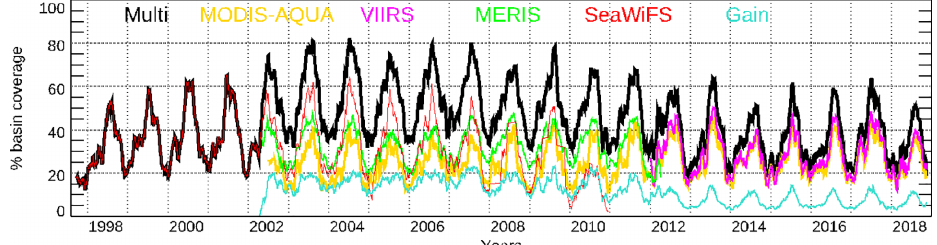
Figure 8. Time series of the number of pixels for each satellite sensor as a percent with respect to the basin total coverage. For the sake of readability, each line represents the result of the 30-day running median time series. The turquoise line is the basin coverage increase that is gained with the Multi product with respect to the maximum coverage from the single sensors.